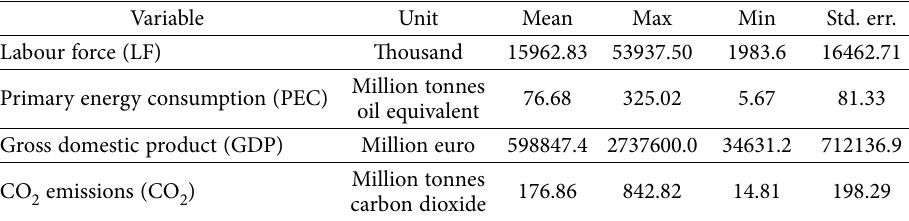
Fig. 9. PEC in million tonnes of oil equivalent and CO Table 1. Descriptive statistics of research sample